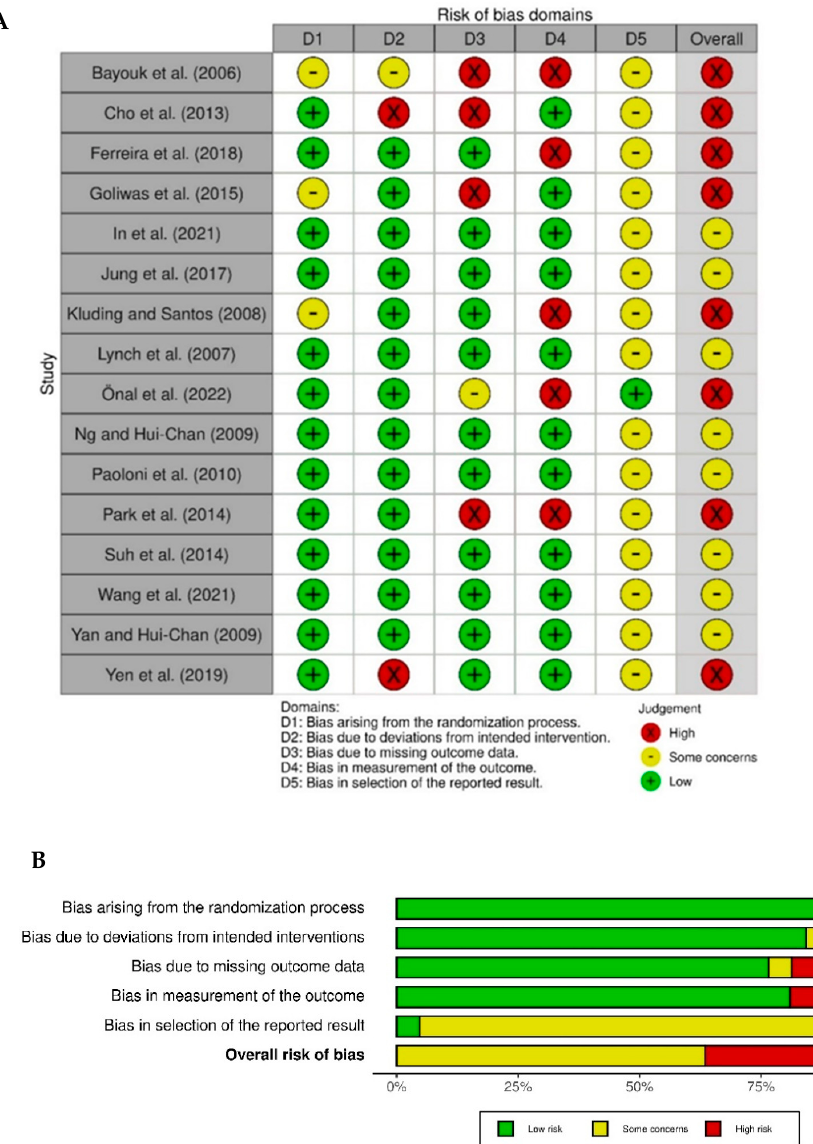
Figure 2. Risk of bias assessment using the Cochrane ROB 2 tool. ( A ) Review of authors’ judgements for each domain within the ROB 2 tool. ( B ) Risk of bias assessment summary—collective risk of bias of all studies (%) using the ROB 2 tool